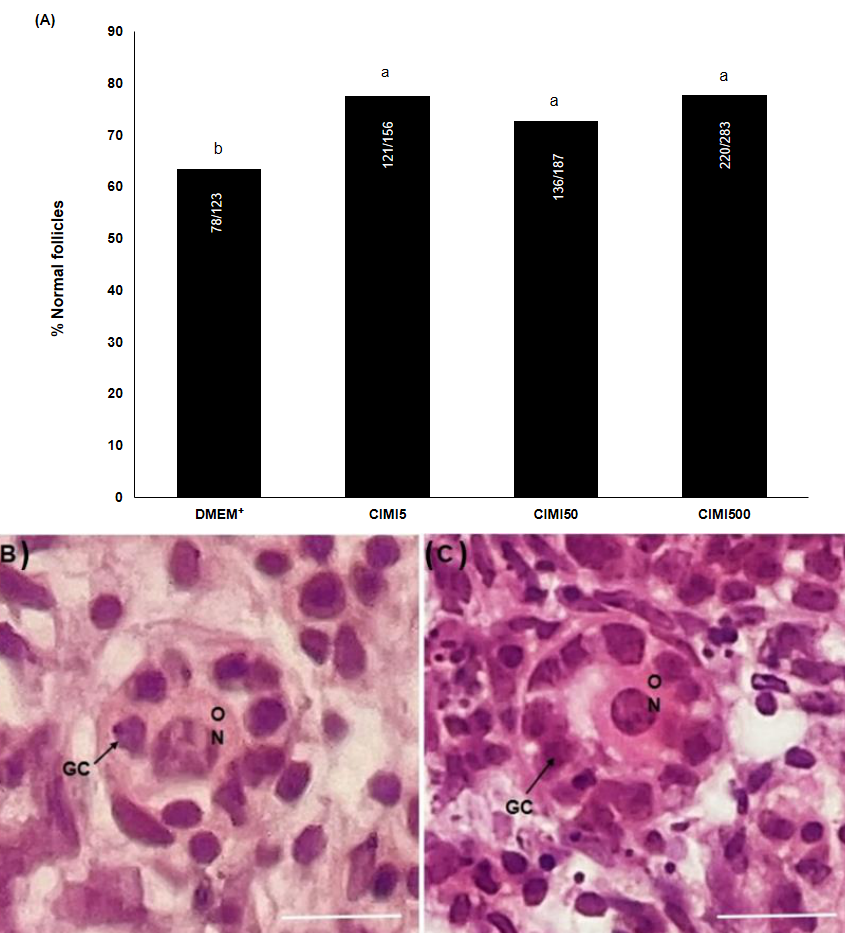
Figure 1. The percentage of normal follicles in ovaries after 6 days of culture in DMEM + alone or supplemented with CIMI (5 ng/mL, 50 ng/mL or 500 ng/mL) ( A ). Histological sections of degenerated follicle cultured in DMEM + ( B ). Normal preantral follicles cultured in the presence of CIMI (5 ng/mL) ( C ). The percentage of normal follicles was compared by chi-square test. a and b different lowercase letters indicate statistically significant differences between treatments ( p < 0.05). Numbers of follicles evaluated are shown within each column. a,b: different lowercase letters indicate statistically significant differences between treatments ( p < 0.05). O: oocyte, GC: granulosa cells; N: nucleus. Scale bar: 100 μm (400 ×).